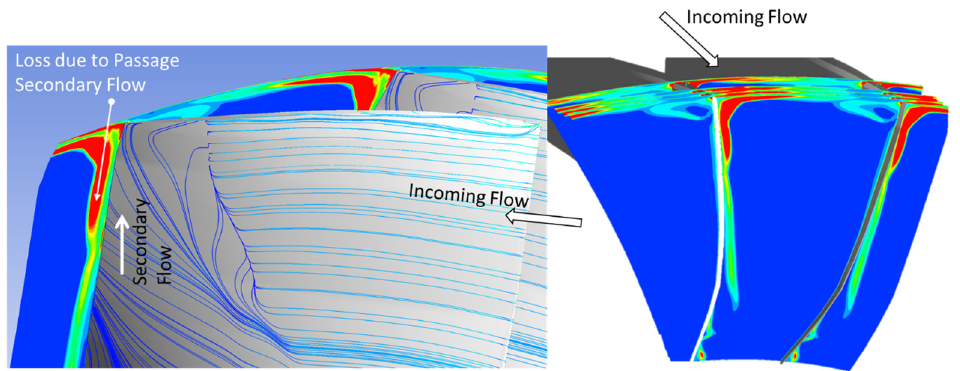
Figure 12. EGR contours in the strong ‐ shock section.